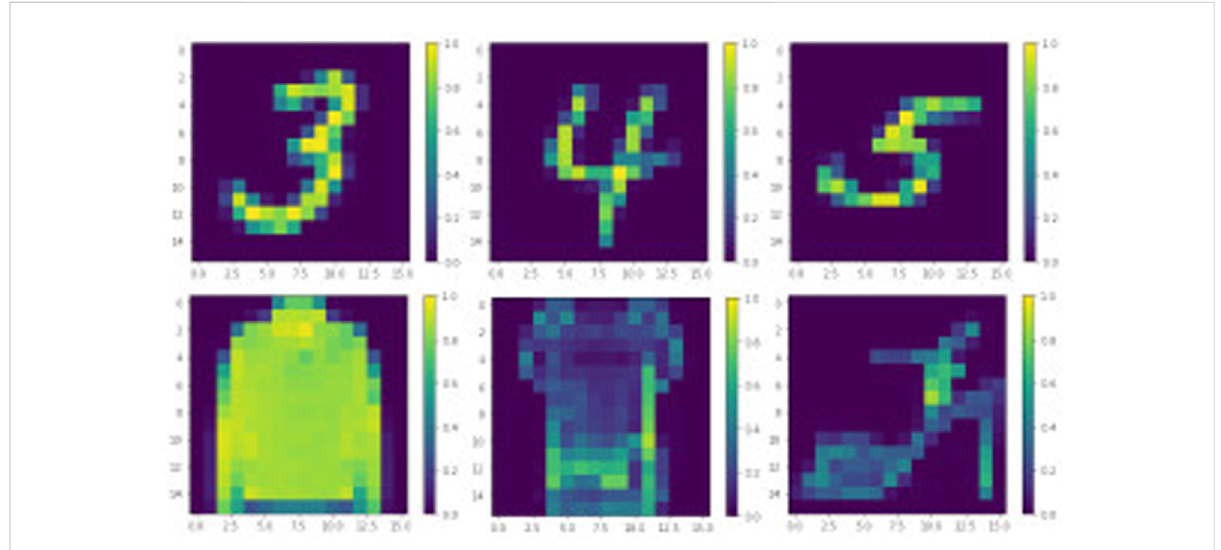
FIGURE 5 Examples of MNIST digits (top) and MNIST fashion (buttom) images used in